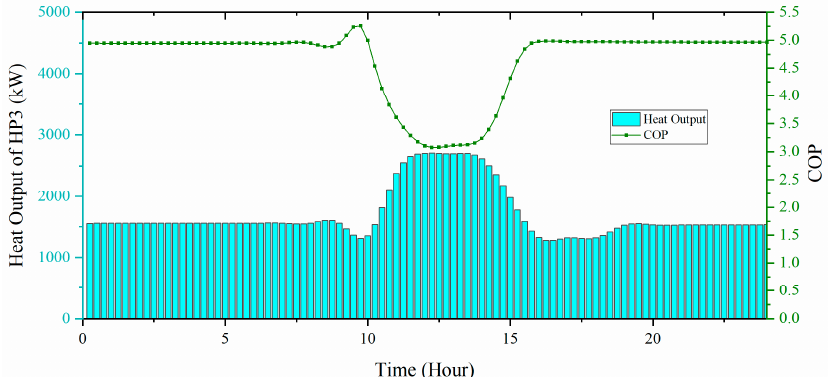
Figure 9. Operation results of heat pumps in heat output.